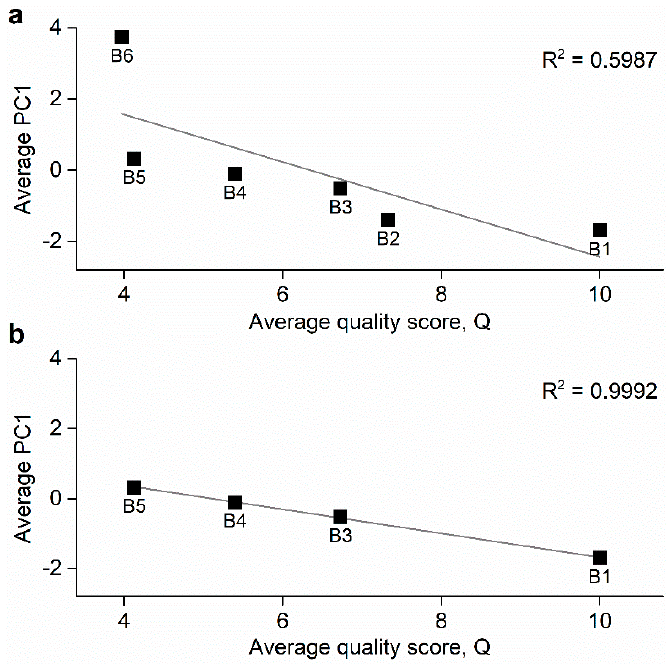
Figure 3. ( a ) Correlation between average quality scores, according to Equation (1), calculated from panel tests and average principal component 1 (PC1) obtained from the electronic olfactory system (EOS). ( b ) Correlation between average quality scores, according to Equation (1), calculated from panel tests and average PC1 obtained from the EOS excluding the data corresponding to B2 and B6.